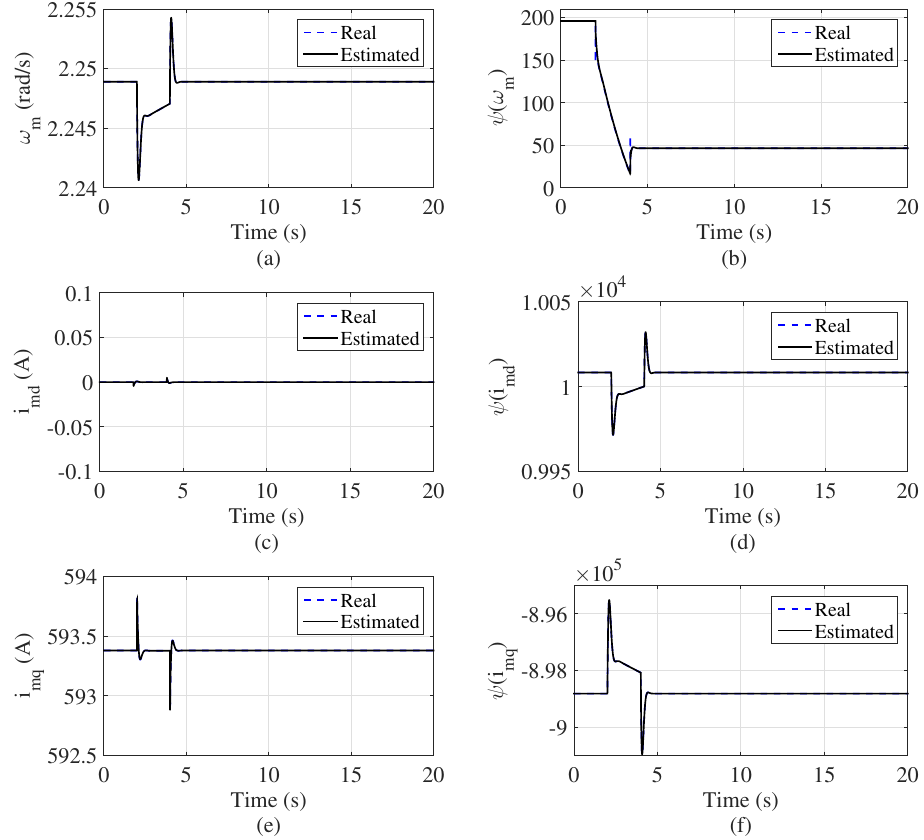
Figure 6. Estimations of states and perturbations. ( a ) Estimation of mechanical rotation speed ω m . ( b ) Estimation of perturbation term Ψ 1 . ( c ) Estimation of i md . ( d ) Estimation of perturbation term Ψ 2 . ( e ) Estimation of i mq . ( f ) Estimation of perturbation term Ψ 3